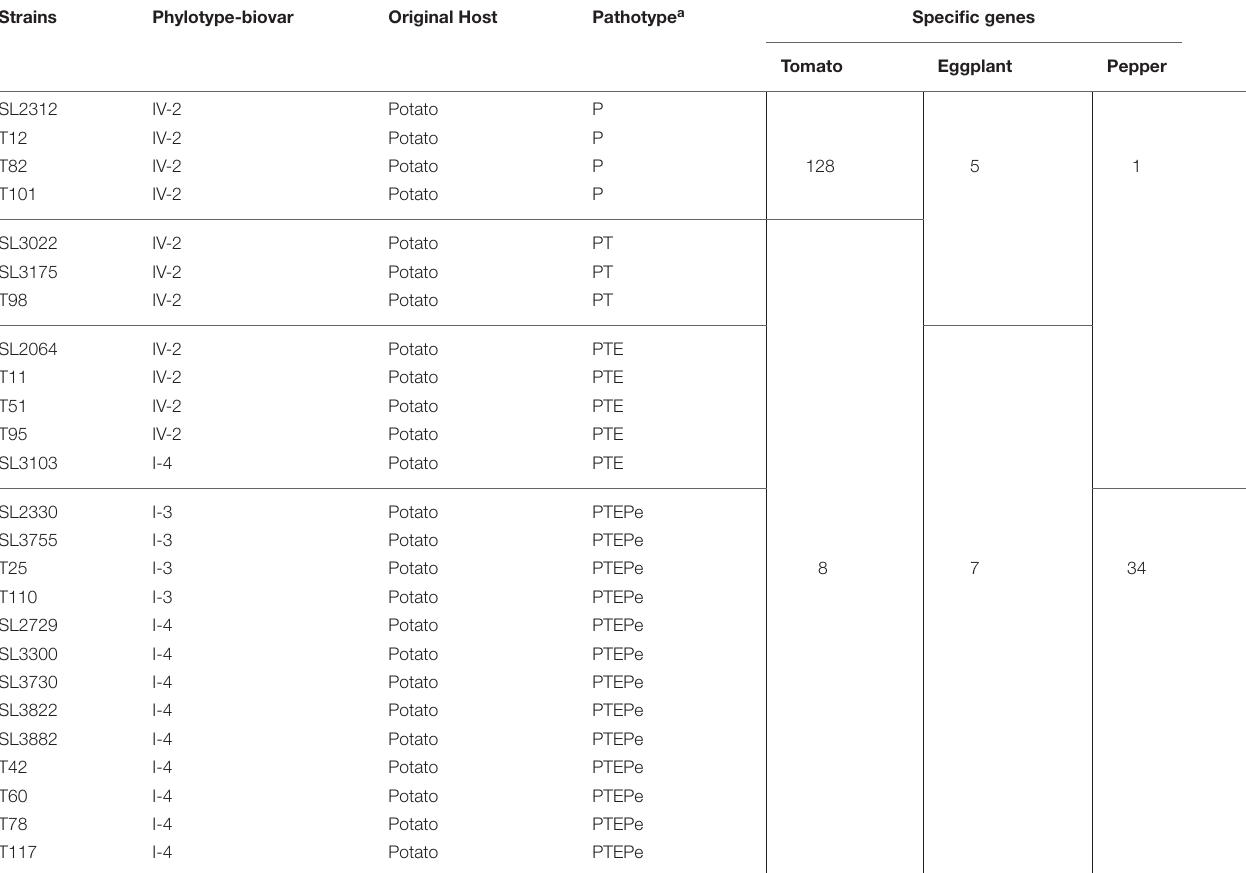
TABLE 2 | Specific gene numbers of RSSC strains that are pathogenic and nonpathogenic toward tomato, eggplant, and pepper. Strains Phylotype-biovar Original Host Pathotype a Specific genes Tomato Eggplant